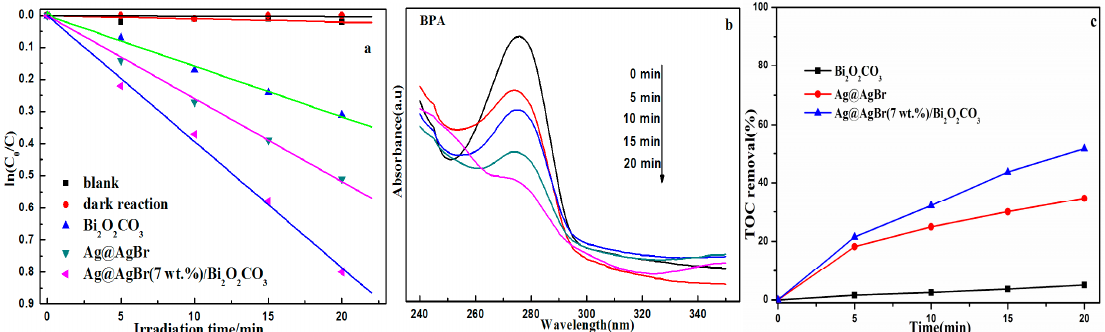
14 of 19 Figure 12. Nyquist plots of Bi 2 O 2 CO 3 , Ag@AgBr(3 wt %)/Bi 2 O 2 CO 3 , Ag@AgBr(7 wt %)/Bi 2 O 2 CO 3 and Ag@AgBr(11 wt %)/Bi 2 O 2 CO 3 photoelectrodes in 0.1 M Na 2 SO 4 solution (pH = 6.7). The photocatalytic activity of Ag@AgBr(7 wt %)/Bi 2 O 2 CO 3 is assessed by studying the photodecomposition of colorless BPA in aqueous solution under visible light irradiation ( λ > 420 nm). As can be seen in Figure 13a, the photolysis of BPA is negligible in the absence of a photocatalyst, suggesting that the degradation of BPA is induced by photocatalysis. The changes in the concentration of BPA caused by adsorption to the catalyst material were also determined in the absence of light, also showing a negligible degradation of BPA. Only approximately 27.1% and 40.2% BPA was shown to be degraded by pure Bi 2 O 2 CO 3 and Ag@AgBr under visible light irradiation, respectively. The Ag@AgBr(7 wt %)/Bi 2 O 2 CO 3 composite displayed the highest activity as well as a BPA removal efficiency of 54.9%, which was attained within 20 min. Figure 13b displays the changes in the concentration of BPA versus irradiation time. Within 20 min of visible light irradiation, the intensity of the absorption peak of BPA at 279 nm decreased dramatically as the irradiation time increased. By considering the results from photocatalytic degradation experiments, shown in Figure 13, it can be concluded that the prepared Ag@AgBr/Bi 2 O 2 CO 3 samples exhibit better photocatalytic